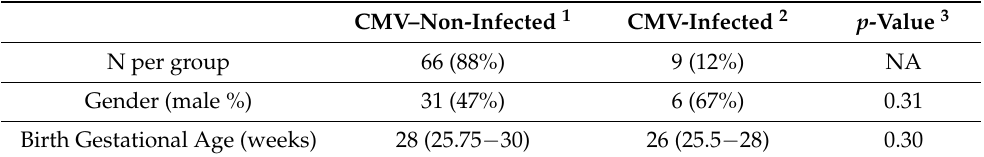
Table 5. Baseline characteristics of infants exposed to CMV through breast milk. Data are median [interquartile range] or N (%). Fisher’s exact test used for categorical variables; Mann–Whitney test used for continuous